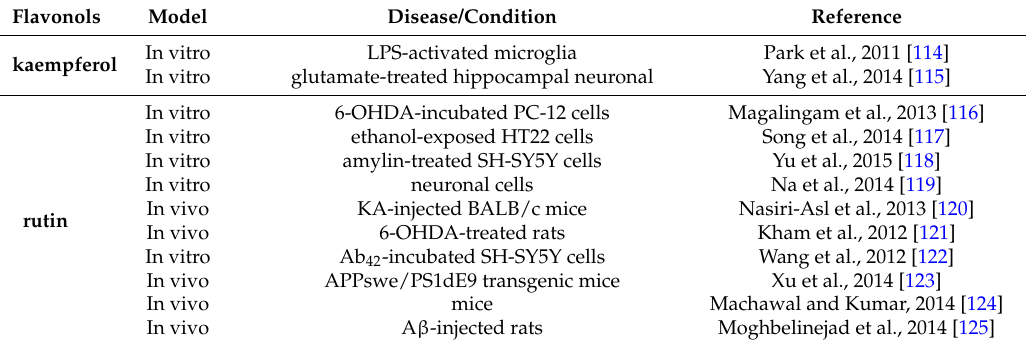
Table 3. Citrus flavonols kaempferol and rutin in models of neurodegenerations.